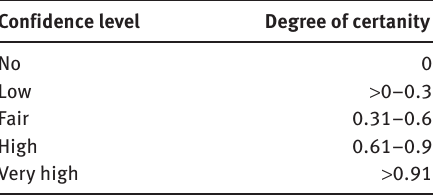
Table 4: Evaluators’ Evaluation Confidence